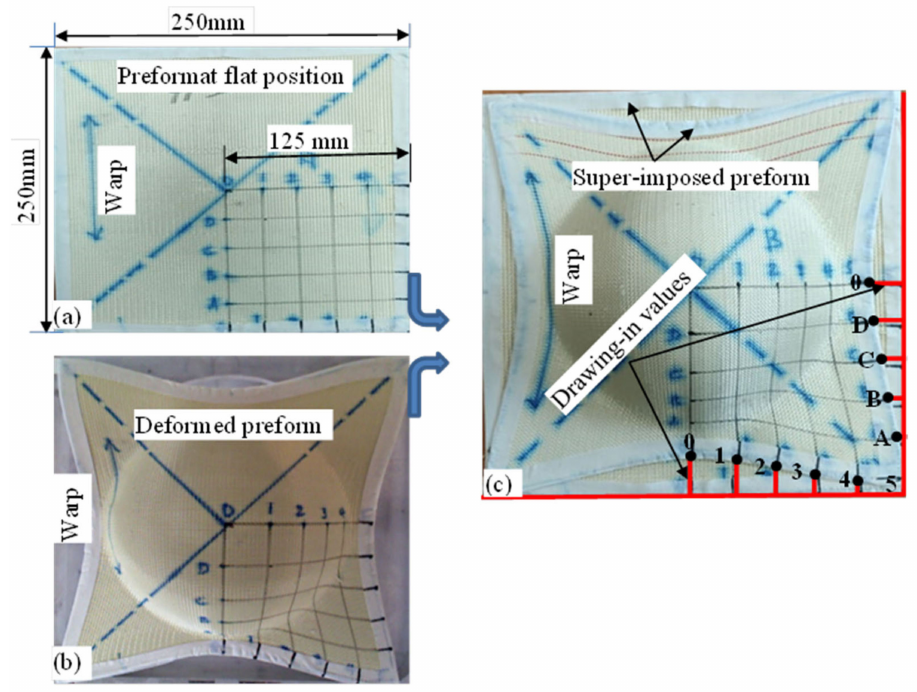
Figure 10. ( a ) Flat, ( b ) deformed, and ( c ) flat and deformed preform super-imposing to compute the drawing-in values of 3D warp interlock preforms at di ff erent positions.